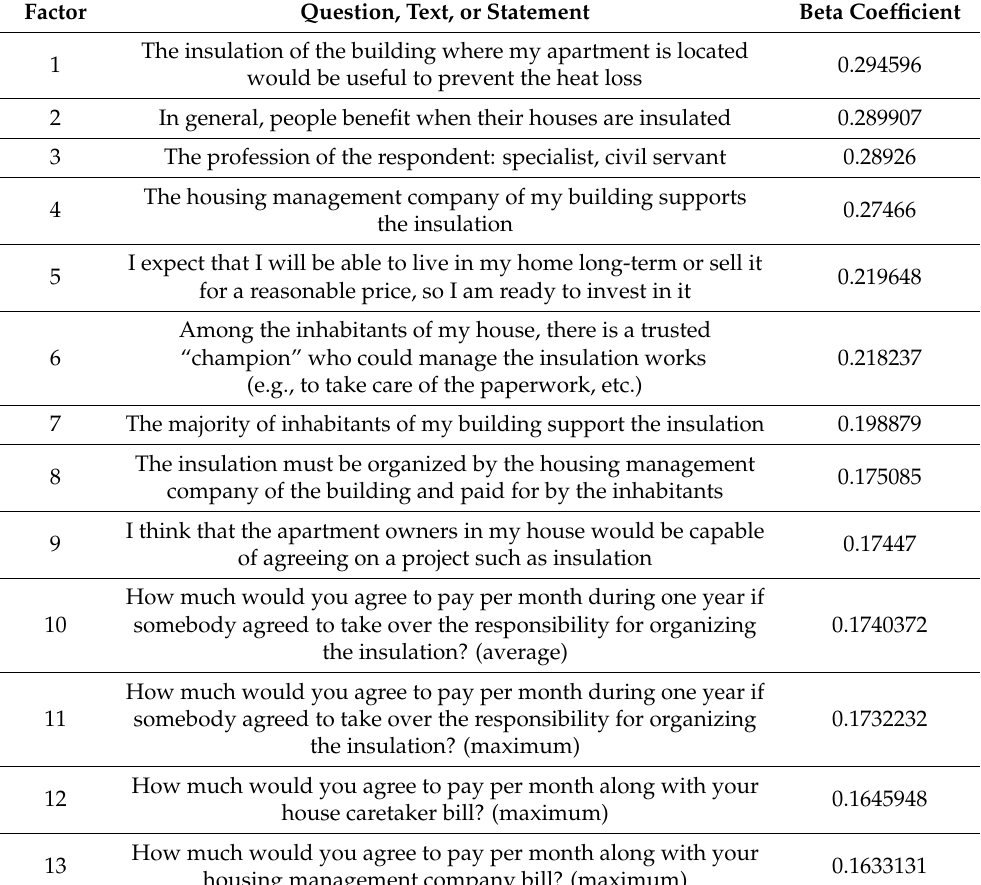
Table 1. Results of regression